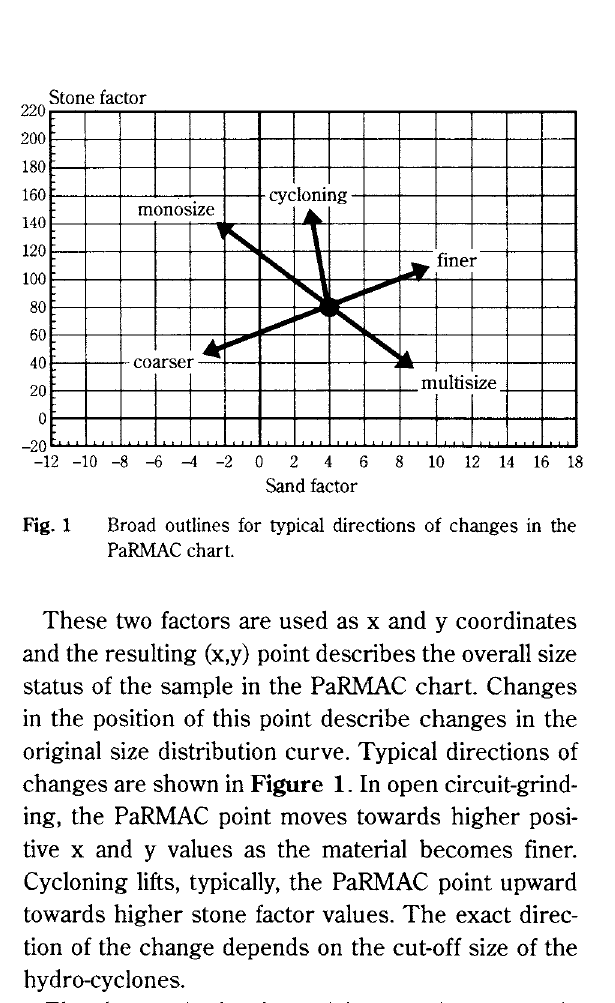
Fig. 1 Broad outlines for typical directions of changes in the PaRMAC